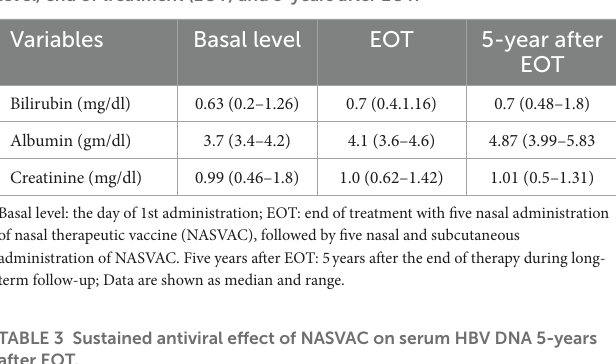
TABLE 2 Parameters of liver and kidney function of 60 patients at a basal level, end of treatment (EOT) and 5-years after